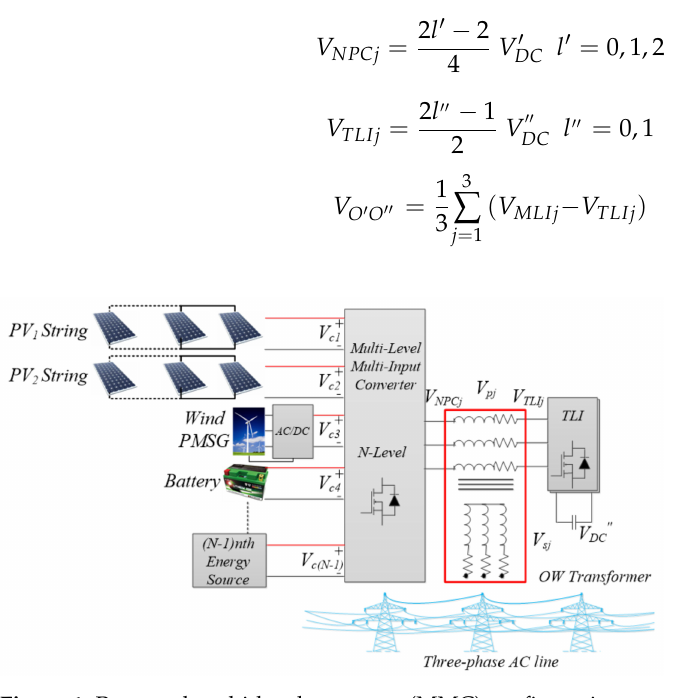
Figure 1. Proposed multi-level converter (MMC) configuration.